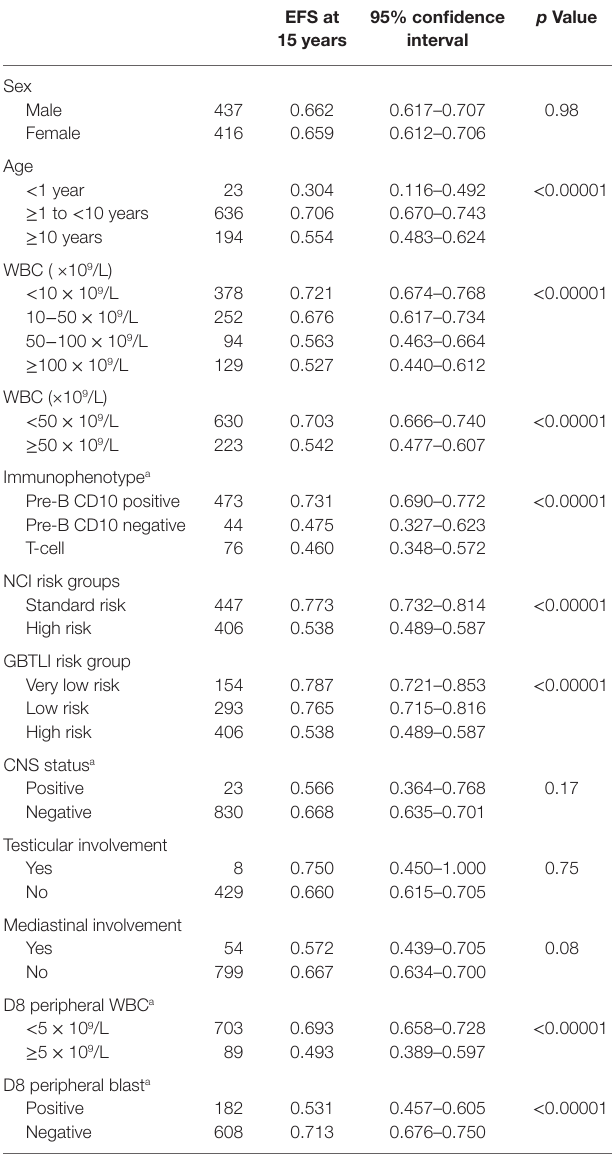
TaBle 5 | Treatment results according to clinical and laboratorial data of 853 all patients treated with the gBTli all-93 protocol.